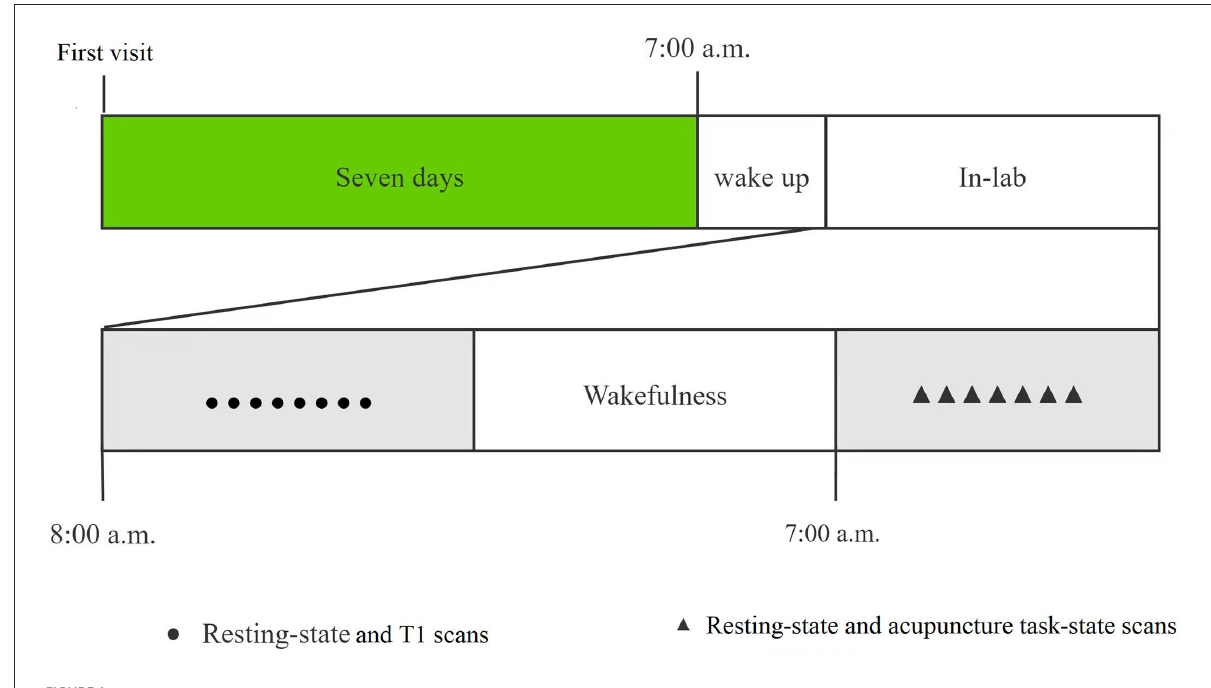
FIGURE1 The flowchart of study